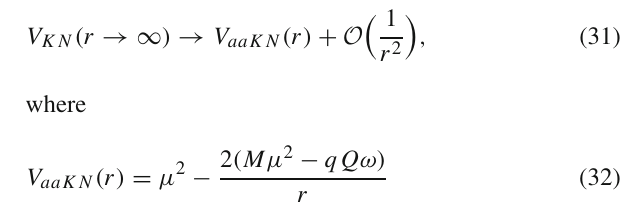
At this stage, it is worth noting that V aK N ( r ) with a = 0 and λ lm = l ( l + 1 ) and V aaK N ( r )